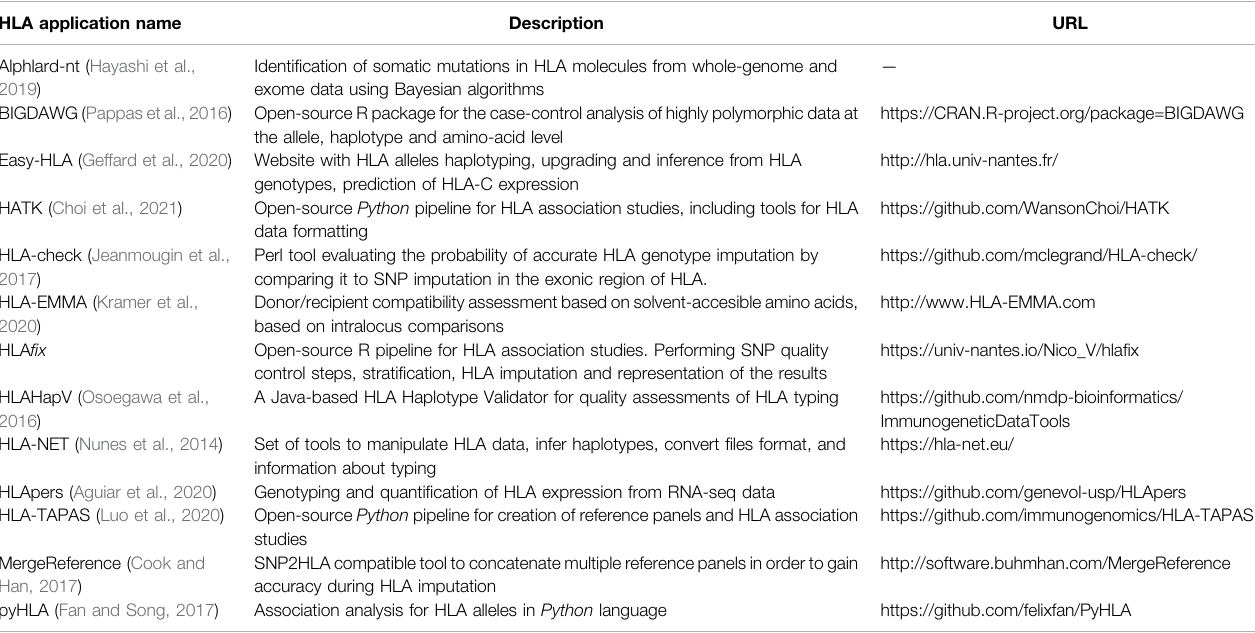
TABLE 1 | Tools for HLA